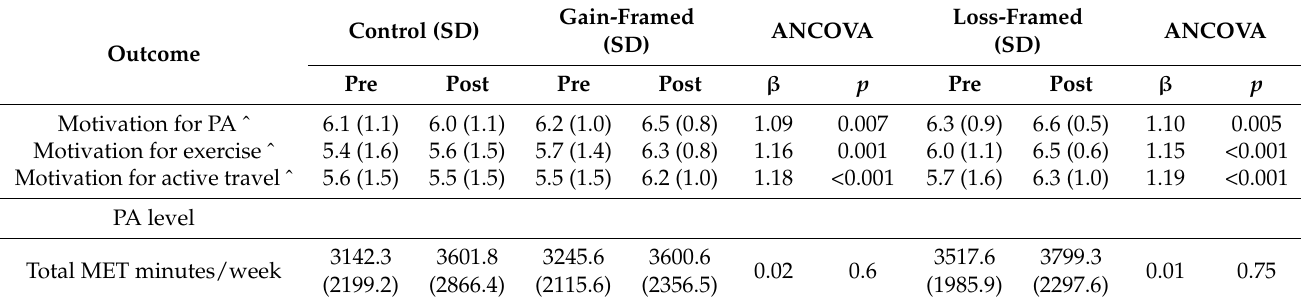
Table 3. Pre-post change in motivation and PA levels: mean, standard deviation, and effect size ( β ) estimation via ANCOVA.